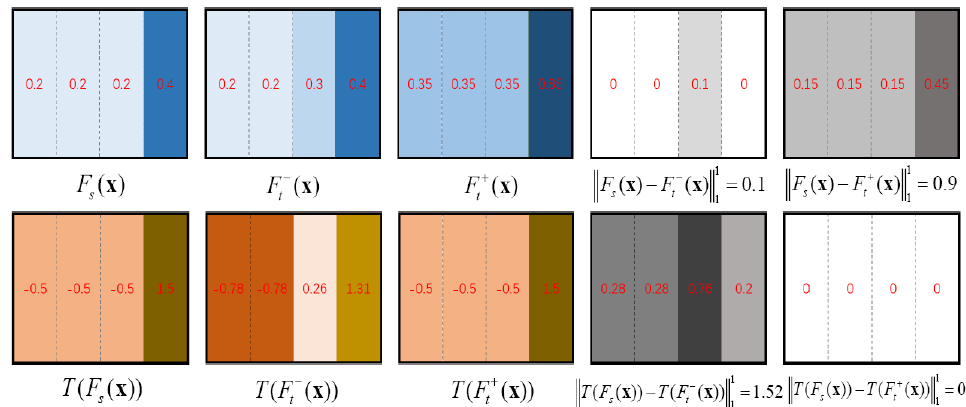
Figure 2. Visual comparison of the discriminability between C p (F s (x),F t (y)) and C(F s (x),F t (y))